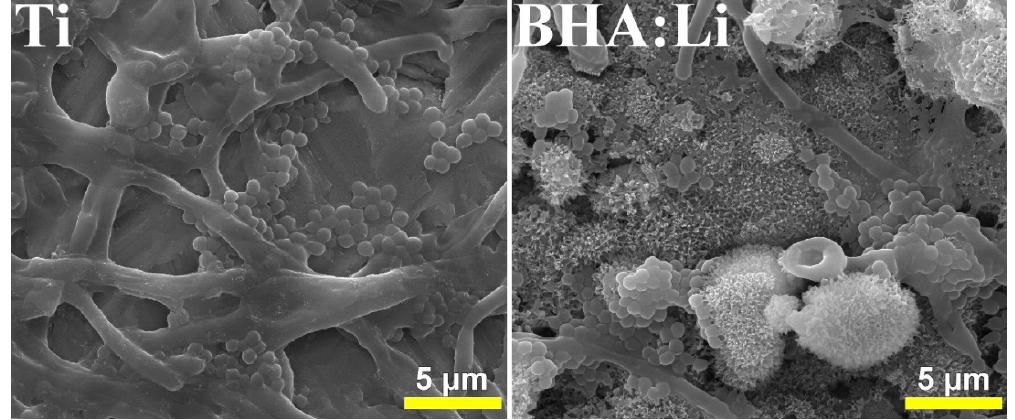
Figure 12. SEM images corresponding to C. albicans biofilm after 72 h of development on the surfaces of Ti and bovine hydroxyapatite doped with Li 2 O coatings.